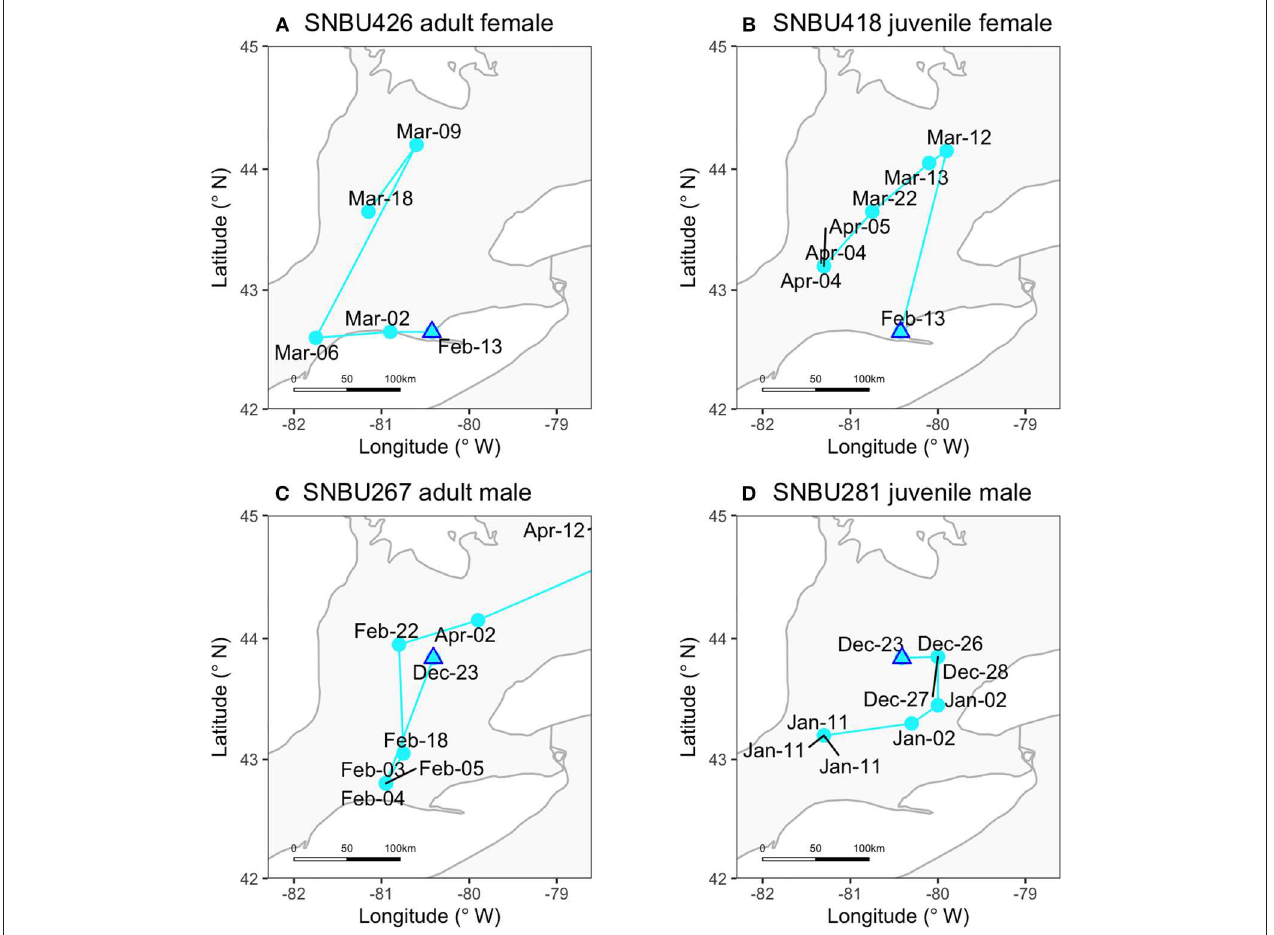
FIGURE 3 | Examples of individual bird movements in the winter. Labels for points indicate detections per hour (i.e., when the same date appears more than once the bird was detected over > 1-h period). The females shown here (A,B) were from Winter 1, and the males (C,D) were from Winter 2. “Adult” refers to birds that have had 1 breeding season and “juvenile” to birds that have yet to return to their breeding grounds.